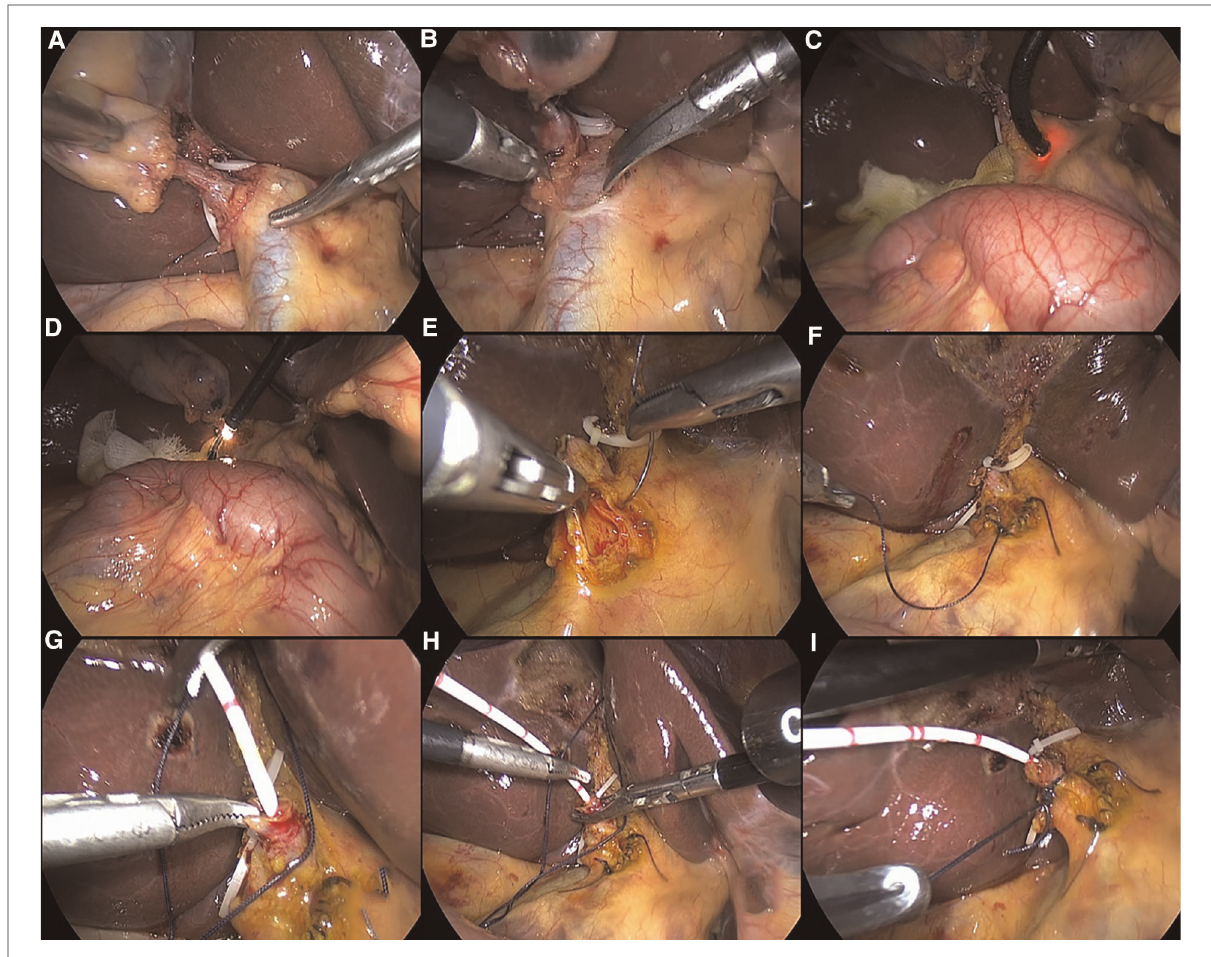
FIGURE 1 Schematic illustration of laparoscopic choledocholithotomy and C-tube drainage. Figures ( A,B ) show the morphology of the cystic duct and common bile duct; Figures ( C,D ) show the process of choledochoscopy and stone removal; Figures ( E,F ) show the procedure of primary suture of the common bile duct; Figure ( G – I ) show the process of the insertion of C-duct through the cystic